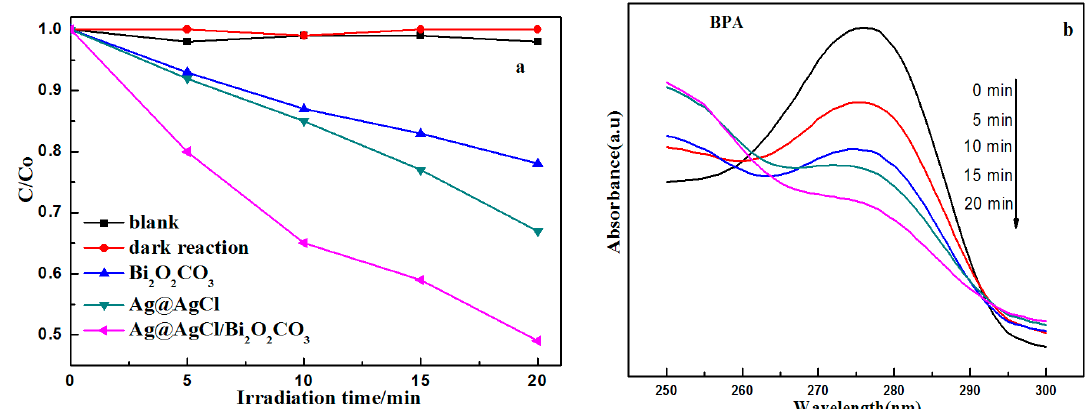
Figure 13. ( a ) Comparison of photocatalytic activities of the as-prepared samples for the photocatalytic degradation of BPA aqueous solutions; and ( b ) UV-vis spectral changes of BPA aqueous solutions in the presence of the Ag@AgCl/Bi 2 O 2 CO 3 sample under visible light irradiation.